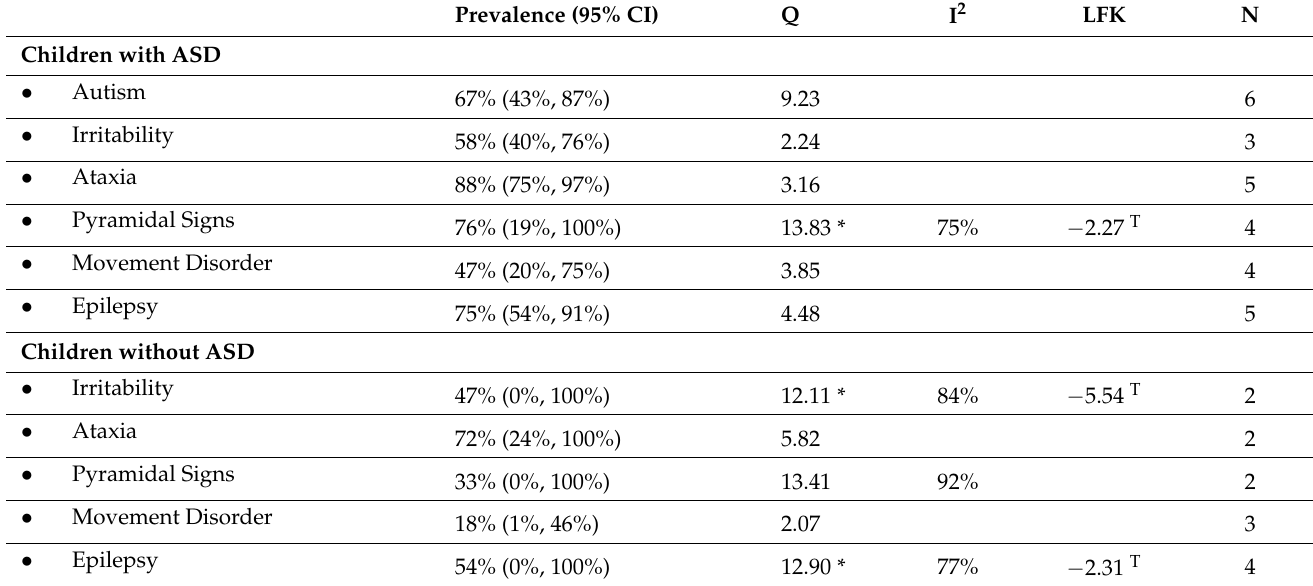
Table 3. Meta-analysis results for the prevalence response to d,l -leucovorin treatment in children with CFD with and without autism spectrum disorder (ASD). Pooled prevalence with 95% confidence interval, Cochran’s Q (Q), Heterogeneity Index (I2), Luis Furuya-Kanamori (LFK) Index and number of studies involved (N). Statistics are estimated by a random-effects model. * p < 0.01; T Significant